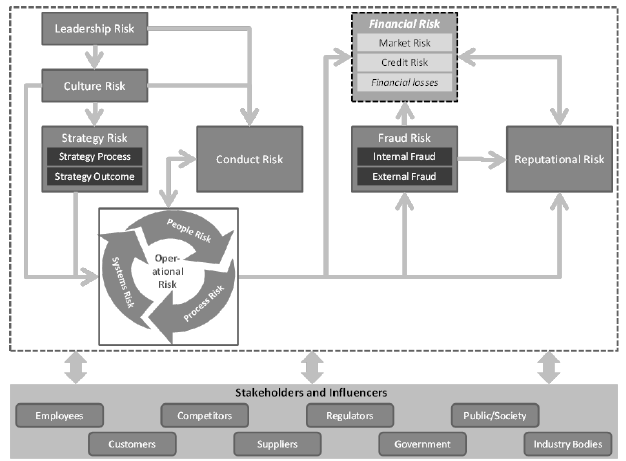
Figure 2: Ecosystem of non-financial